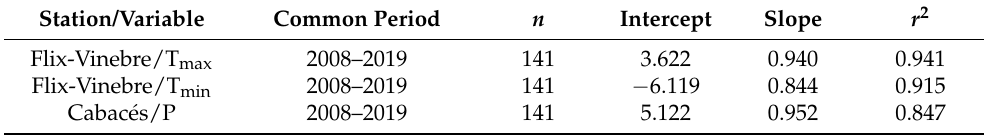
Table A1. Model parameters and determination coefficients ( r 2 ) for the estimation of historical climate values at Ulldemolins from long-term series of alternative meteorological stations. T max and T min , mean monthly maximum and minimum temperature, respectively; P, total monthly